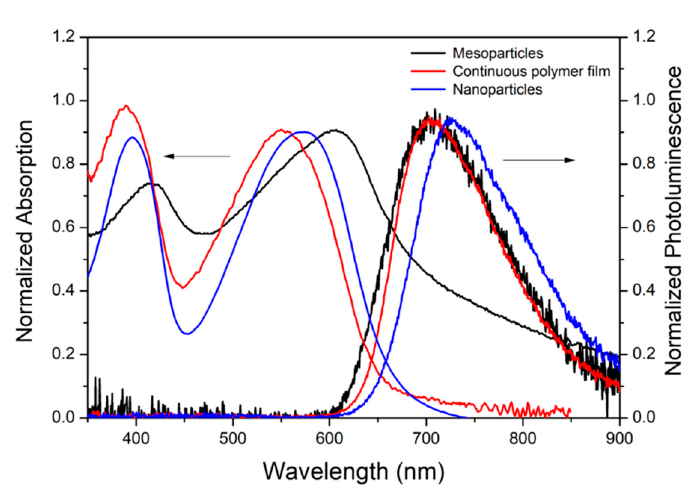
Figure 1. Absorption and emission (rightmost peaks) spectra of the continuous polymer (red line), mesoparticle (black line), and nanoparticle (blue line) spin coated films.